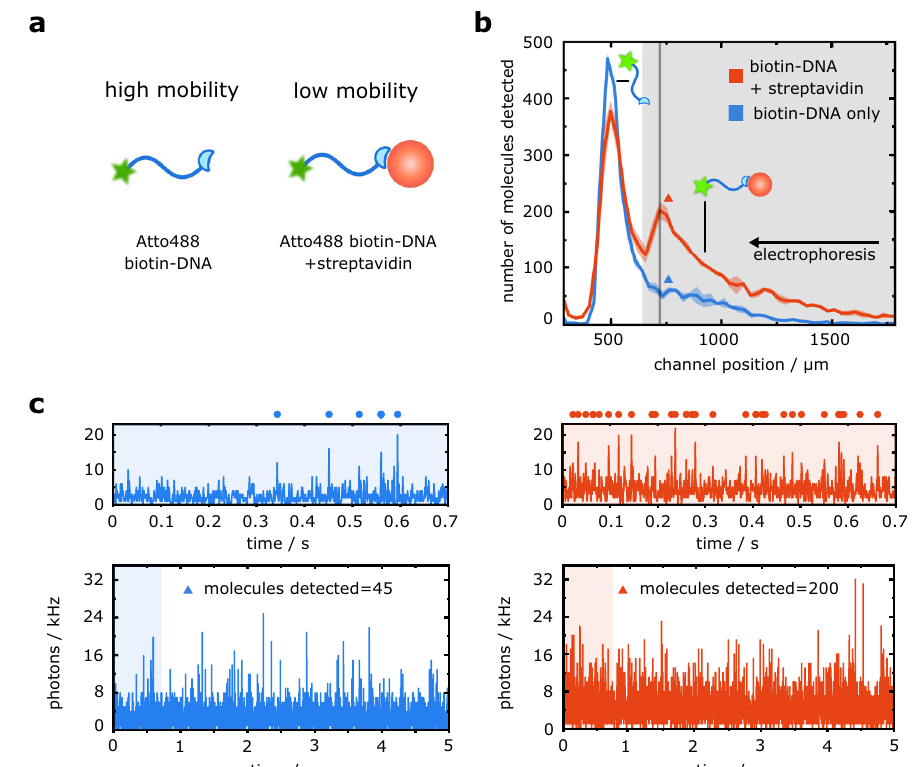
Fig. 2 | Sensing of a biotin – streptavidin complex using the DigitISA platform. a Monovalent streptavidin is added to a biotinylated and fl uorophore-conjugated DNA strand. Binding of the streptavidin species reduces the electrophoretic mobility of biotinylated DNA probe. b Electropherogram as obtained by scanning the confocal volume across the cross-section of the channel in a stepwise manner for the biotin – streptavidin sample mixture (red line; average of N =3 repeats, the shaded bands correspond to the standard deviation) and for the control sample (blue line; average of N =3 repeats, the shaded bands correspond to the standard deviation) at the mid-height of the channel, demonstrating the presence and separation of both streptavidin-bound and nonbound biotinylated